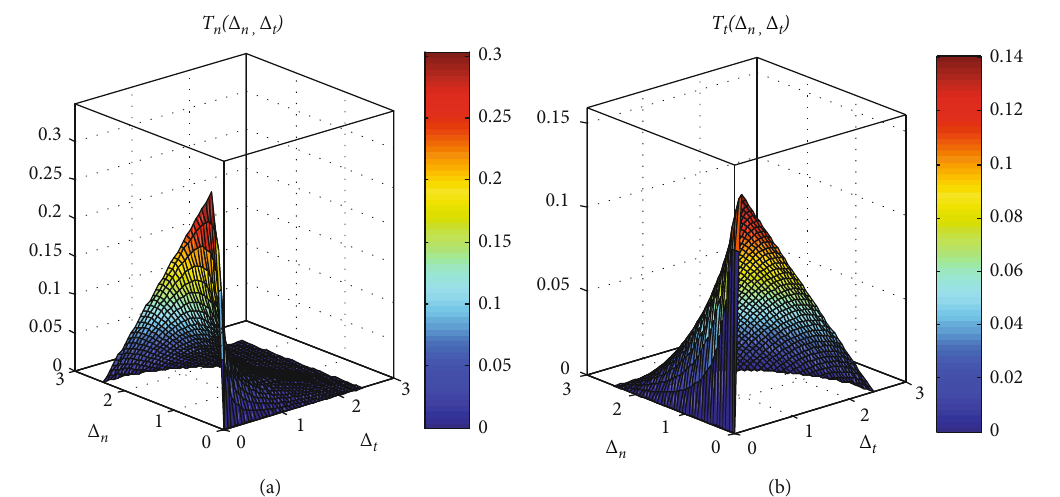
Δ Þ in bilinear CZM in ABAQUS n , t ment are illustrated in Figure 9. Firstly, while the model is compressed until the displacement is -0.05 mm, the stress is increased straightly -0.50 MPa. Then, the model is